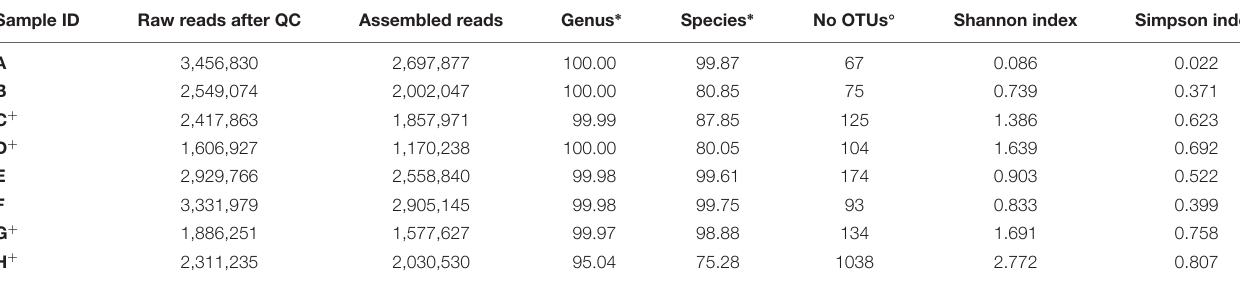
TABLE 2 | Sequencing results of samples with reduced ( + ) or normal chlorine